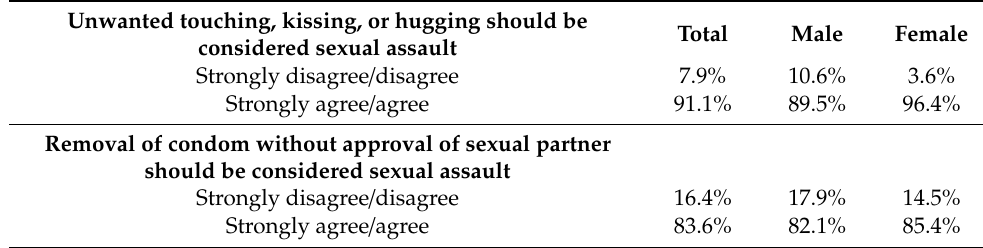
Table 2. Results from quantitative survey on understanding